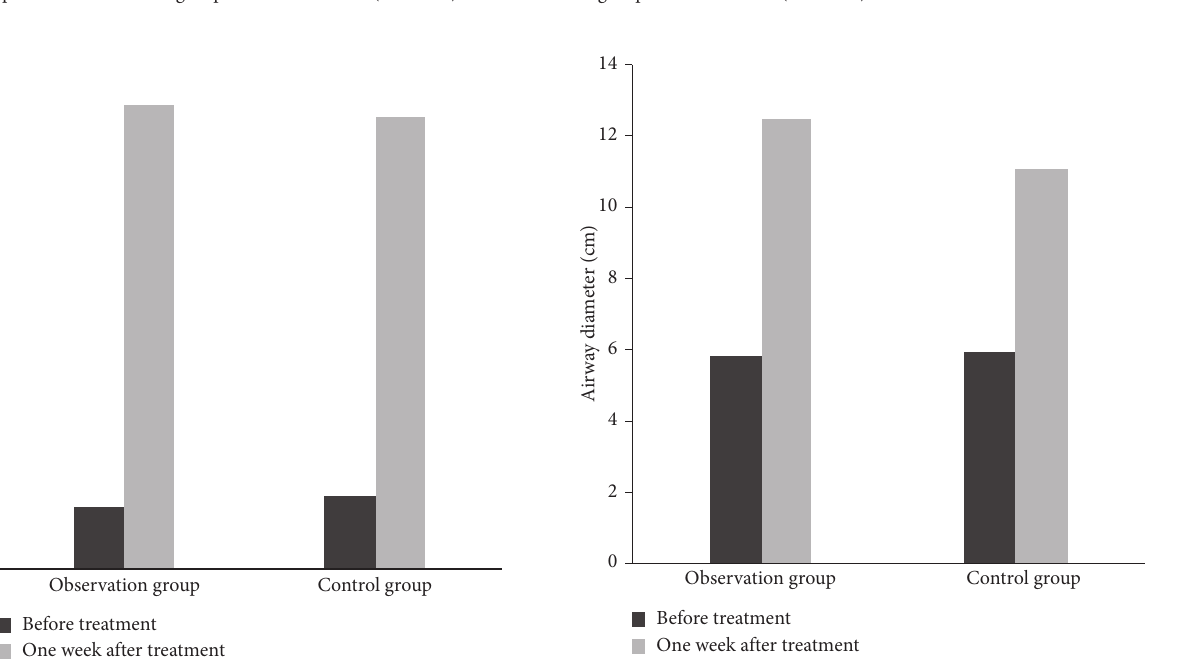
Figure 2: Comparison of shortness of breath score between the two groups. Note: compared with the same group before treatment ( a P < 0 . 05) and the control group after treatment ( b P < 0 . 05).